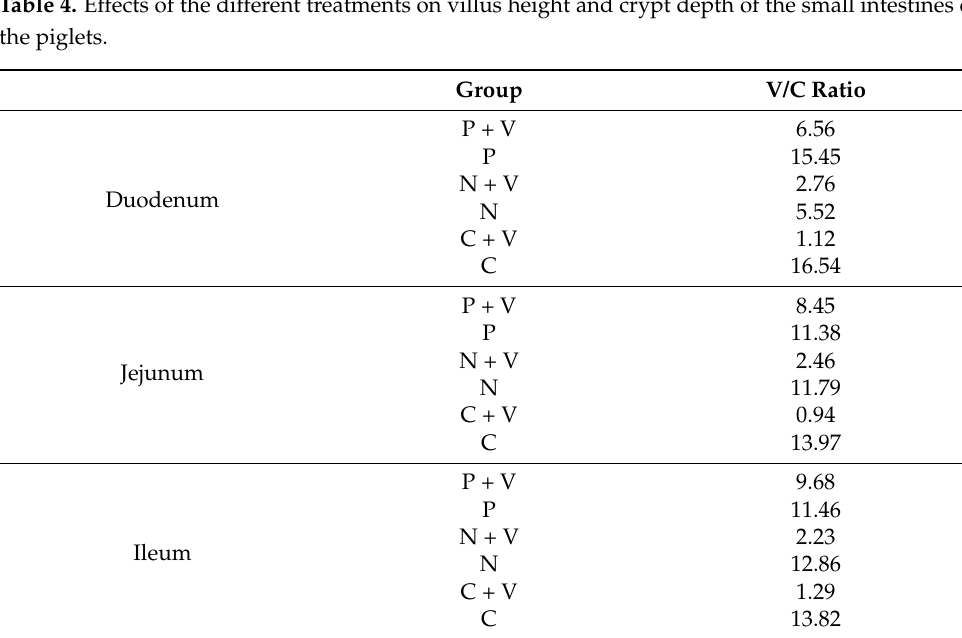
Figure 9. shRNA−expressing plasmids protect piglets from histopathological lesions induced by PDCoV. The small intes- tines of all piglets were collected for histopathological examination.